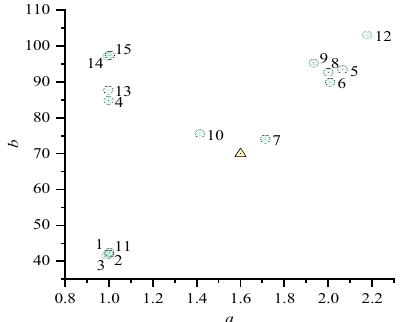
Figure 1. Ratio between time costs of multiplication and addition. Bottom axis: a ; left axis: b .